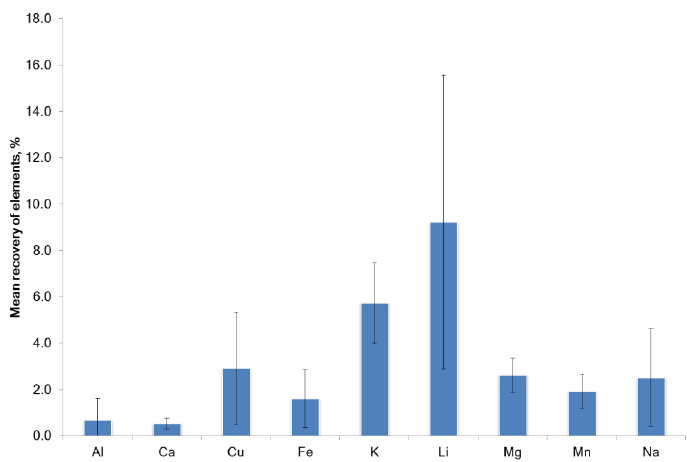
Figure 3. Mean recovery of the elements from G. glabra using NADES and water.